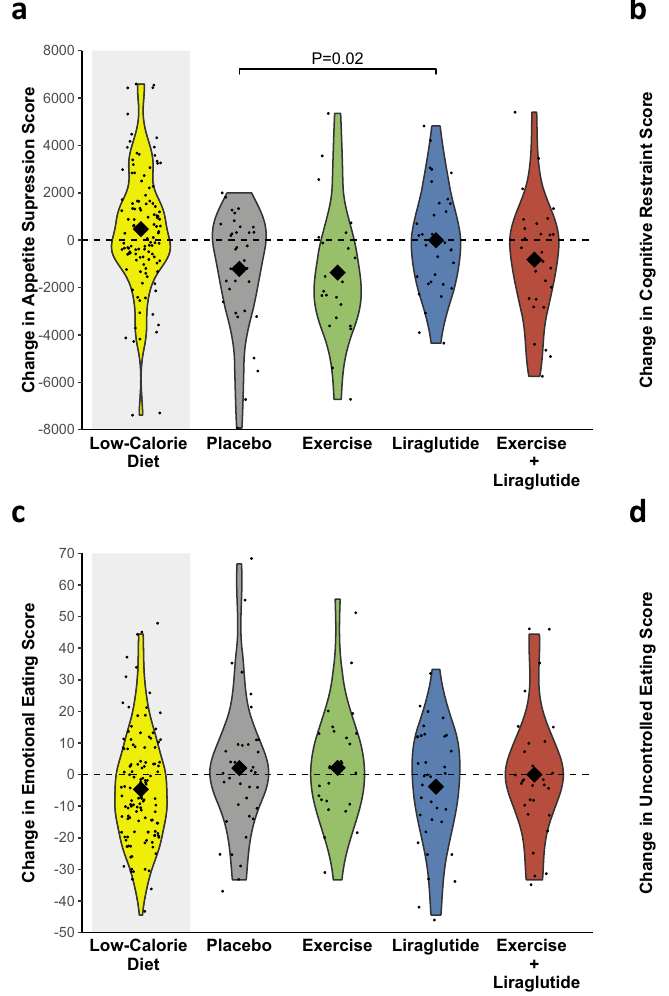
Fig. 1 | Changes in postprandial appetite suppression and eating behavior during the study. Violin plots of observed changes in a postprandial appetite suppression score, b cognitive restraint, c emotional eating, and d uncontrolled eating. Changes are from week − 8 to week 0 (low-calorie diet, yellow color in grey shaded area, n =130) for all groups combined and from week 0 to week 52 (after randomization)inthefourgroups,separately:placebo(greycolor, n =39),exercise (green color, n =26), liraglutide (blue color, n =36), and the combination of lir- aglutide and exercise (red color, n =29). The diamonds indicate observed means and the dots indicate individual observations. The appetite suppression score was